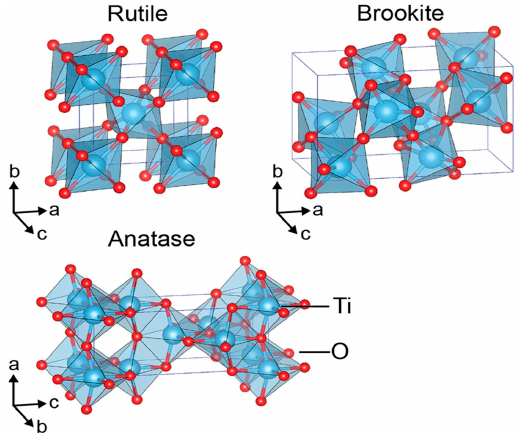
Figure 2. Connecting the chains of distorted TiO 6 octahedra by sharing edges and corners in different ways to form rutile, brookite and anatase polymorphs. Titanium atoms are blue; oxygen atoms are red. Reproduced with permission from [42]. Copyright Nature Publishing Group, 2017.